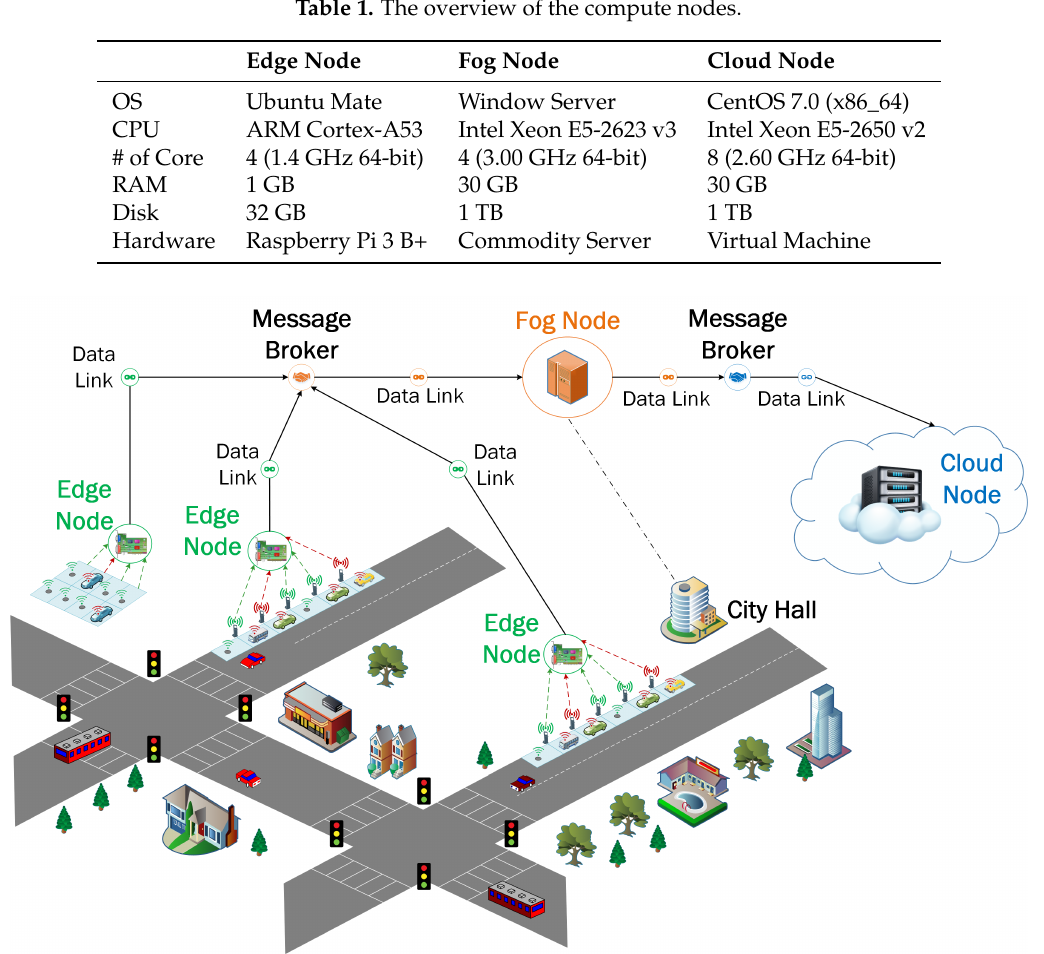
Figure 3. Geographical Distribution of the edge-fog-cloud nodes for the smart parking